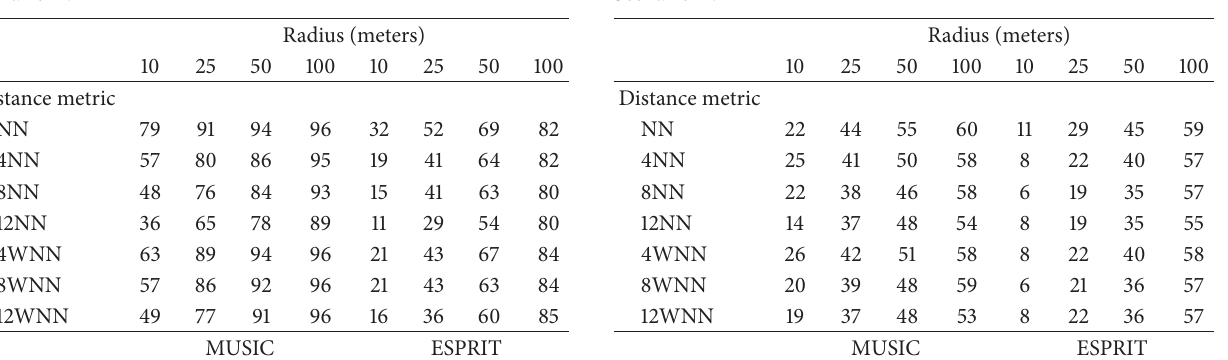
Table 1: Number of “hits” within given radius to actual location for each distance metric out of 100 trials. SNR = 30 dB; number of antennas = 8; oversampling factor = 2; distance-threshold = 0.2, Scenario A.